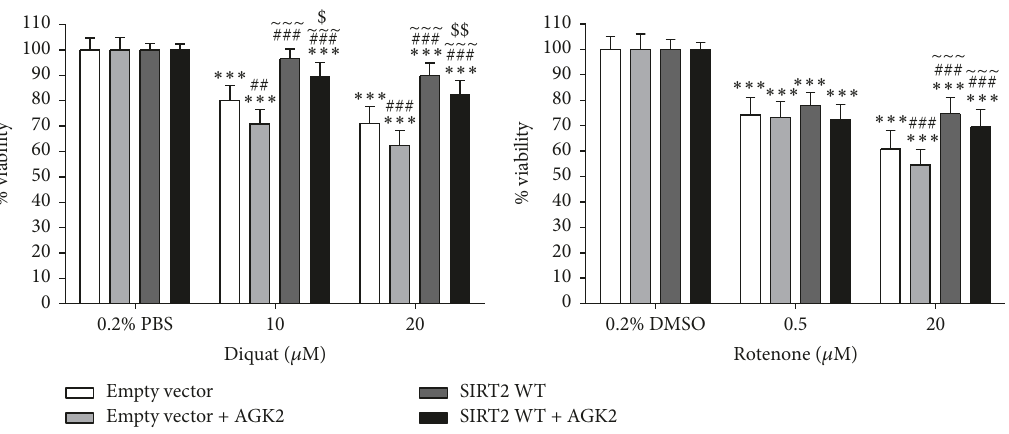
Figure 1: The effect of SIRT2 overexpression and inhibition was determined in toxin treated SH-SY5Y cells. SIRT2 was overexpressed in SH-SY5Y cells and control cells were transfected with empty vector following which one set of cells was treated with toxin alone and another with SIRT2 inhibitor AGK2 and toxin for 20 hours and viability measured by reduction of Alamar Blue. Toxins used: diquat (20 𝜇 M or 10 𝜇 M) or rotenone (20 𝜇 M or 0.5 𝜇 M) treated cells. Data are presented as fold- untreated ( ± SD) from three independent assays ( 𝑛 = 3 ). ∗∗∗ 𝑝 < 0.001 when compared to 0.2% vehicle (PBS or DMSO), one-way ANOVA (Bonferroni corrected), ### 𝑝 < 0.001 and ## 𝑝 < 0.01 when compared to control cells, ∼∼∼ 𝑝 < 0.001 when compared to control + AGK2 treatment, and $$ 𝑝 < 0.01 and $ 𝑝 < 0.05 when compared to SIRT2 cells, two-way ANOVA (Bonferroni